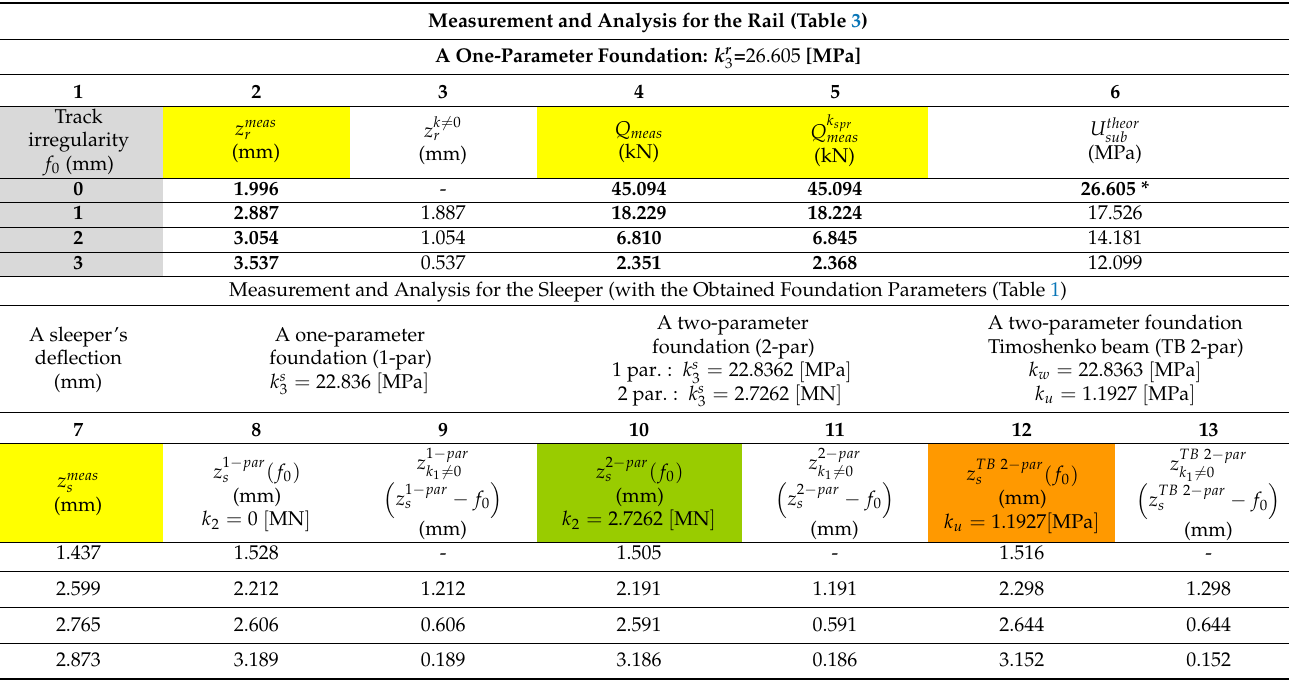
Table 4. The force transferred from the rail on the sleeper and the sleeper’s deflection in consequence of the f 0 irregularity on the track—second axle load for the Figures 3 and 13 with the obtained foundation parameters (Table 1). Measurement and Analysis for the Rail (Table 3) A One-Parameter Foundation: k r 3 = 26.605